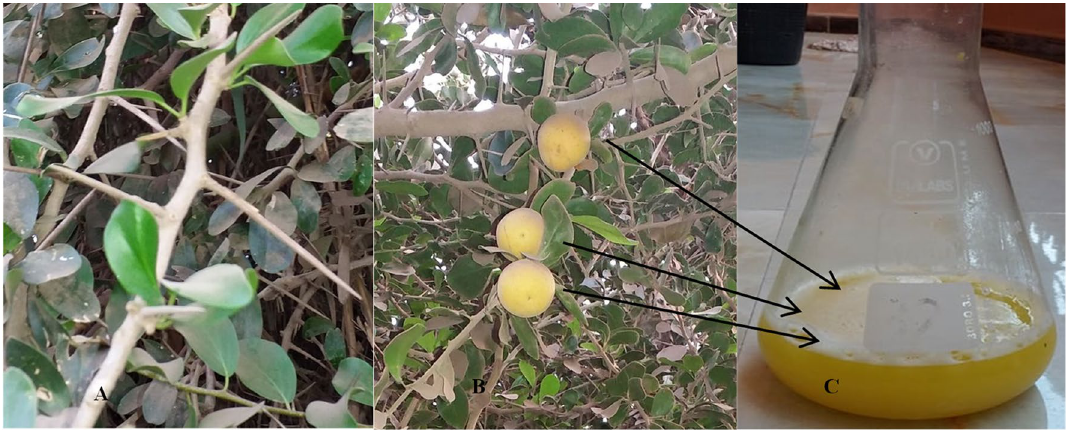
Figure 1. Different parts of D. caffra tree with ( A ) leaves, stem, and spines ( B ) Fruit ripe, and ( C ) its